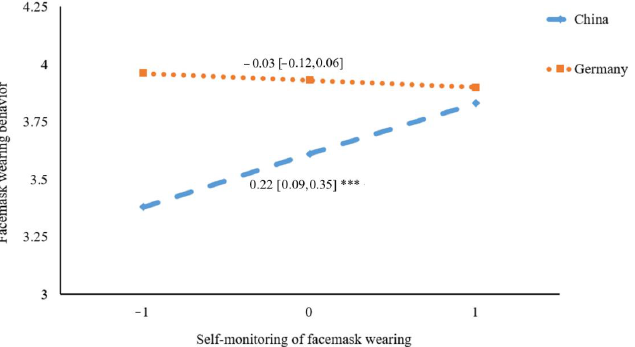
Figure 2. Plot of simple slopes showing the association between self-monitoring and facemask wearing at different countries ( n = 578); *** p < 0.001.